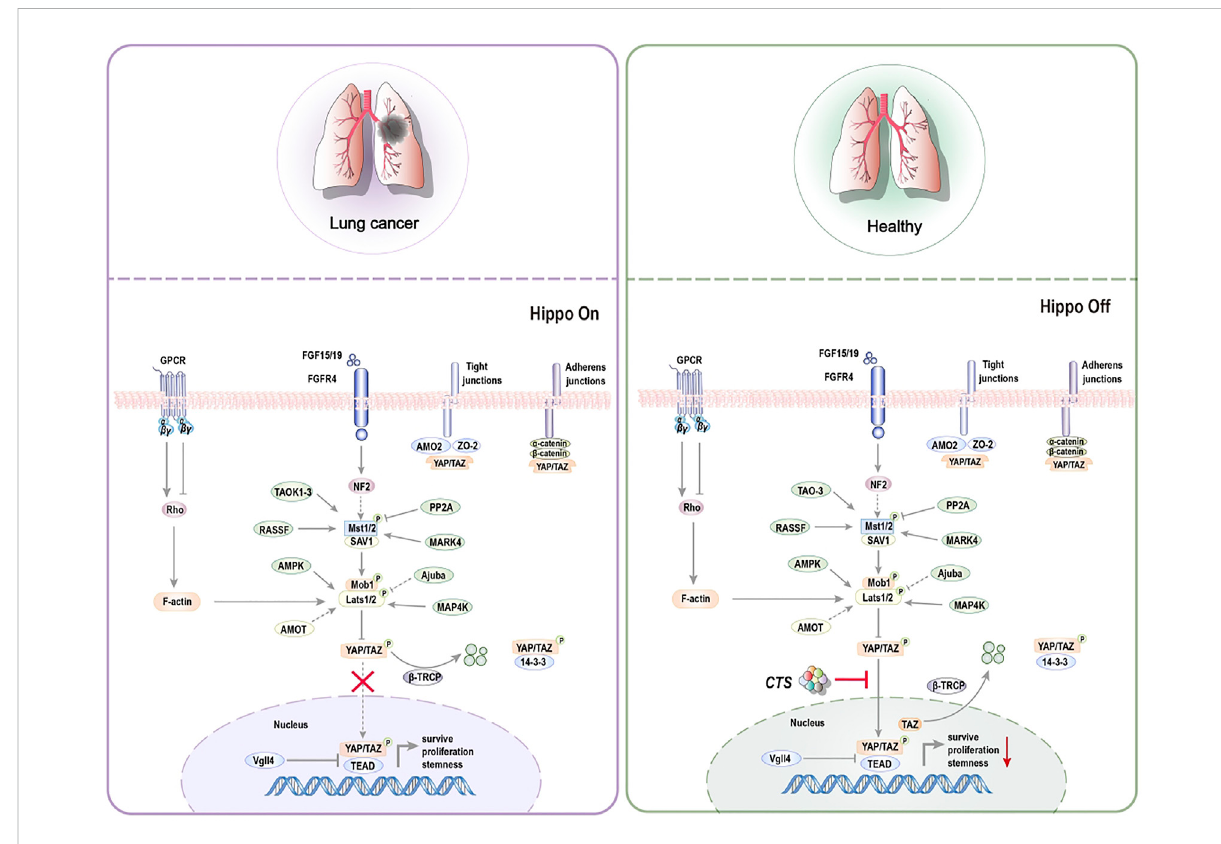
FIGURE 5 Representative scheme illustrating CTS ’ s inhibitory role in the proliferation of NSCL CSCs by regulating the Hippo signaling pathway for the treatment of non-small cell lung